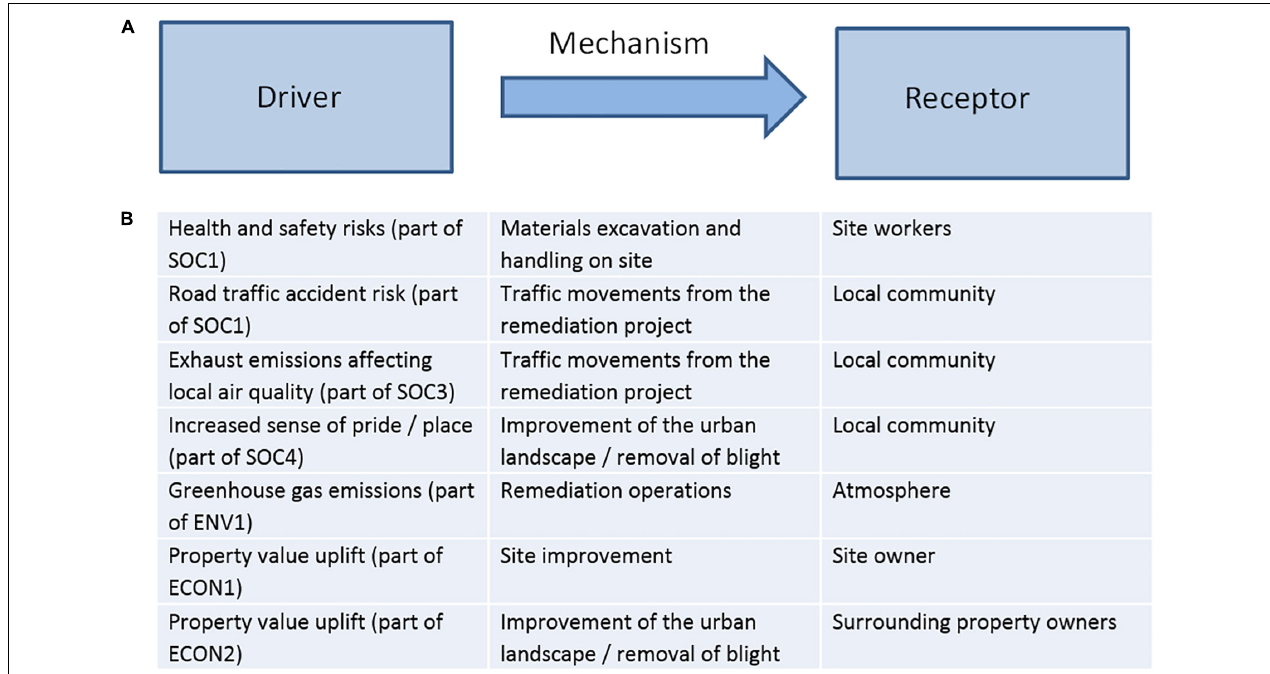
FIGURE 3 | A sustainability linkage (A) , and some possible examples (by no means exhaustive) (B) . Abbreviations in left column refer to SURF-UK Sustainability Assessment Criteria (CL:AIRE, 2011).